Question: Express in one sentence what the figure is showing.
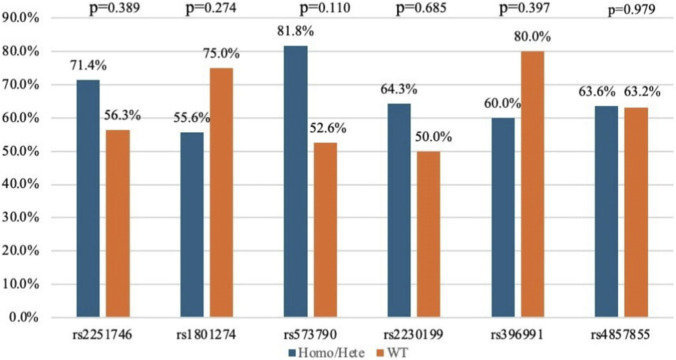
Answer: Clinical improvement by genotype assessed via GINA step. Percentage of patients achieving a reduction of at least one GINA treatment step after 12 months of omalizumab therapy, stratified by genotype for each SNP. Statistical comparisons performed using the Pearson chi-squared test.